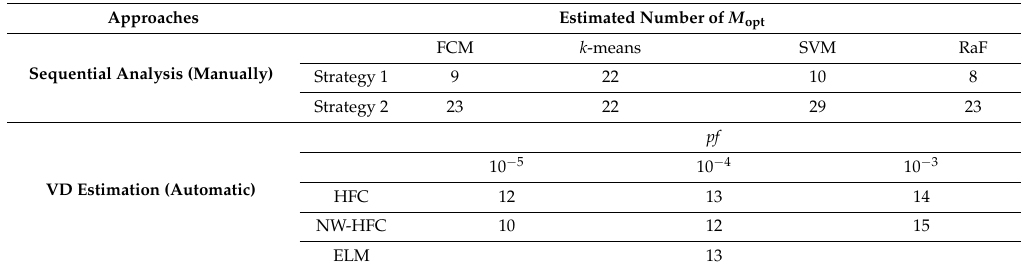
Table 5. Estimation of the optimal number of selected bands (Yancheng dataset).